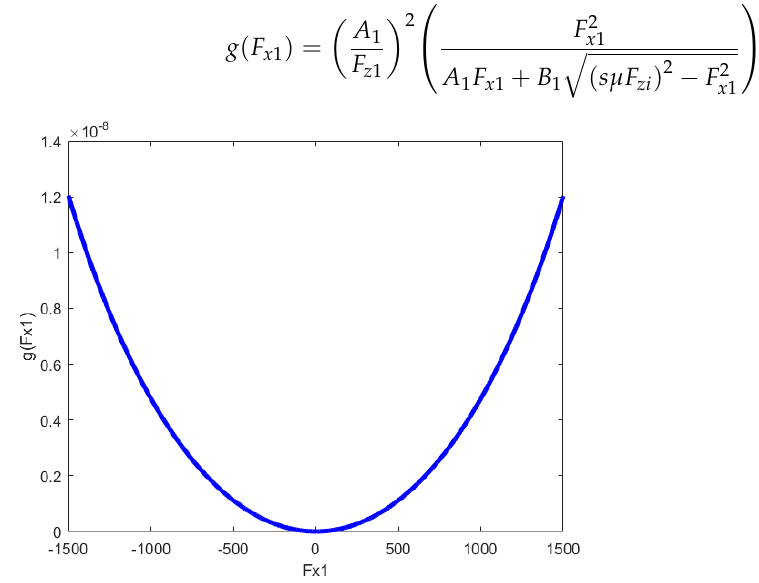
Figure 6. Image of 𝑔(𝐹 (cid:3051)(cid:2869) )